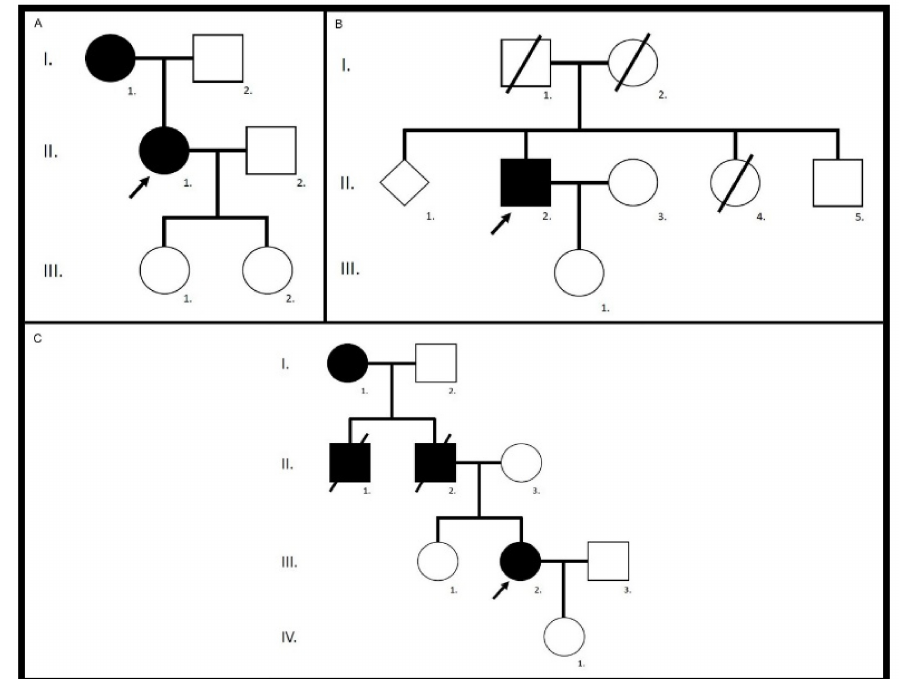
Figure 9. Family trees of the PRPH2 cohort. Family 17, patient II.1 ( A ), family 18, patient II.2 ( B ), and family 19, pa- tient III.2 ( C ).